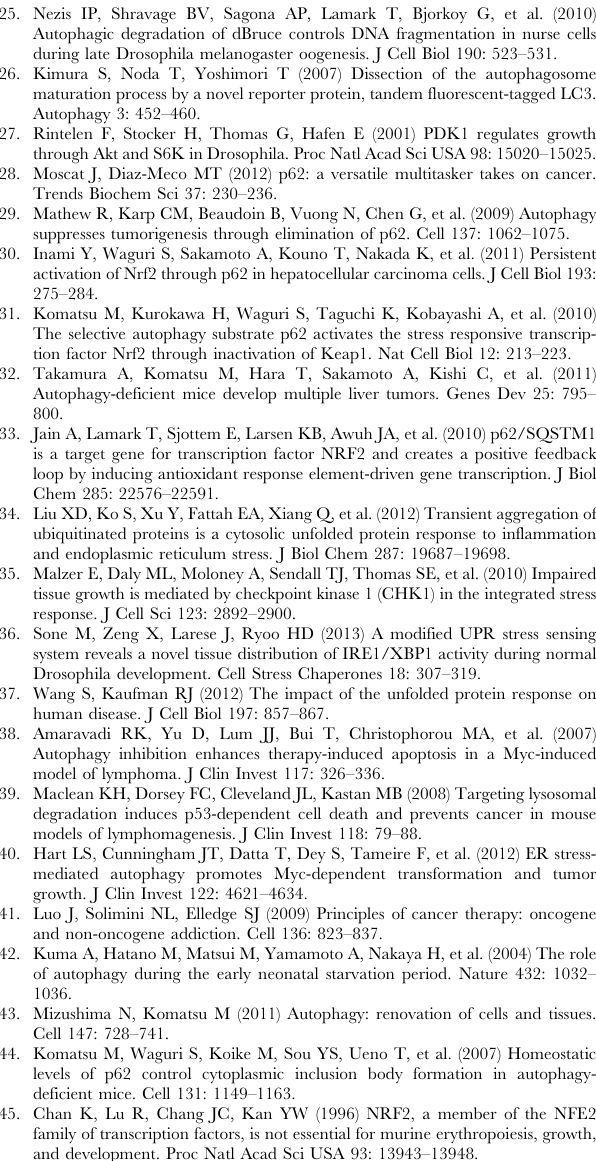
always evaluated from the same image, same tissue, same animal. P values $ 0.05 (considered not statistically significant) are highlighted by a grey background. Please see methods for further details.